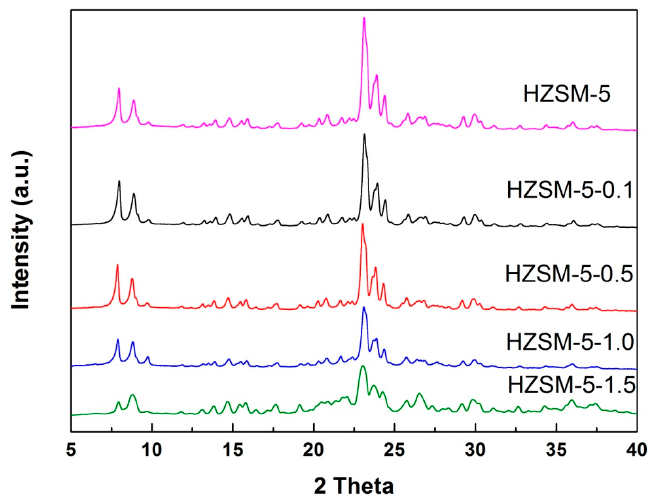
Figure 3. XRD patterns for parent HZSM-5 and the hierarchical HZSM-5 treated with different concentrations of NaOH solution (0.1–1.5 M) at 343 K for 1 h.